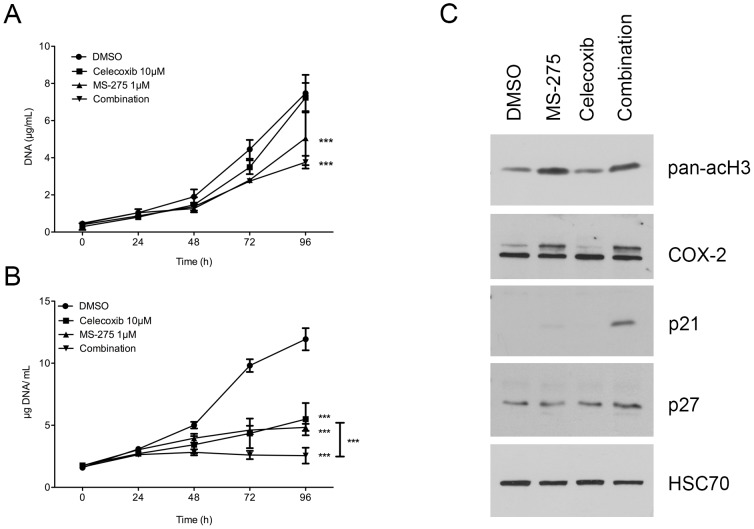
Effect of HDAC and COX-2 coinhibition in PANC-1 and CFPAC-1 cells.(A) Time-dependent effects of MS-275 and celecoxib on PANC-1 cell growth. (B) Time-dependent effects of MS-275 and celecoxib on CFPAC-1 cell growth. (C) Western-blot detection of Cox-2, p21, p27 in 30 µg CFPAC-1 proteins 48h after 1 µM MS-275 and 10 µM celecoxib treatment. HSC70 was used as a loading control. Results are expressed as mean ± s.d., ***P<.001 versus DMSO or indicated conditions. n≥3 in each condition.